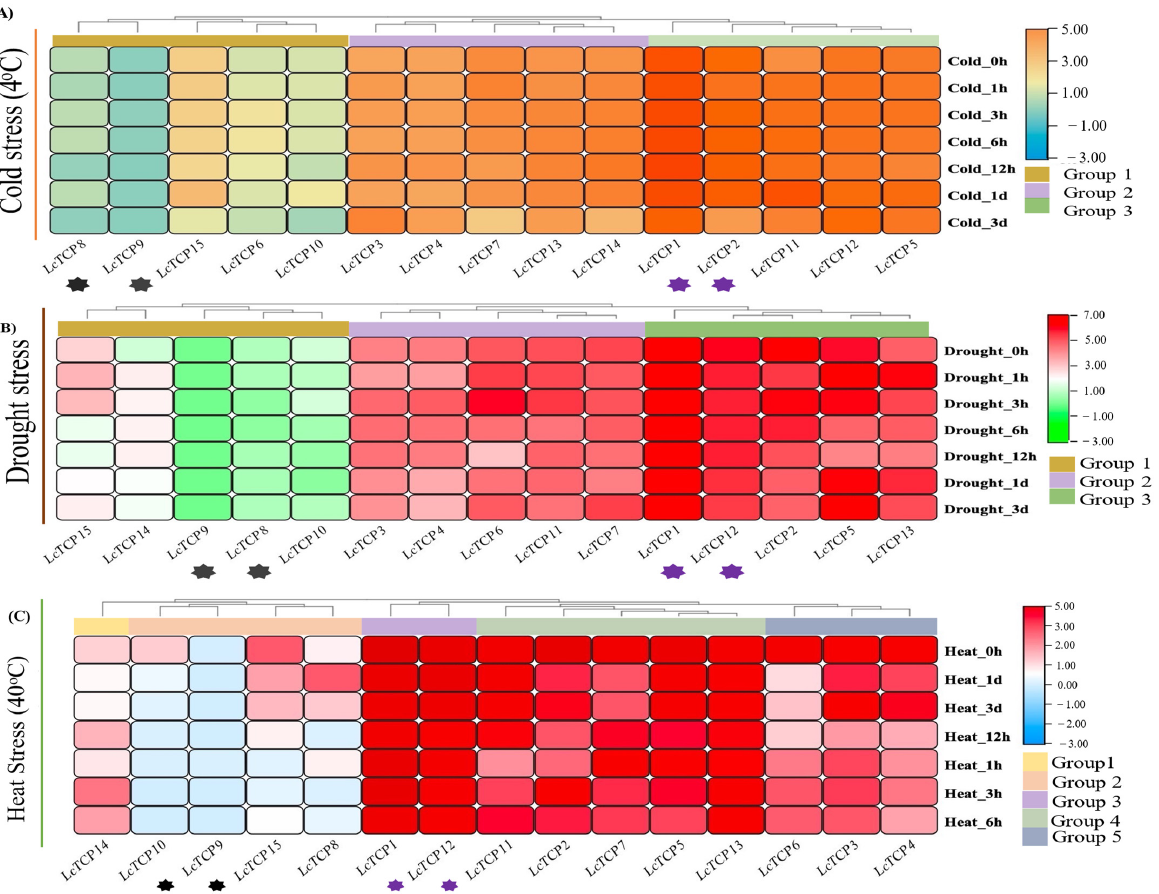
Figure 10. Expression analysis of 15 LcTCPs in six different time points, 1 h (1 h), 3 h, 6 h, 12 h, 1 day (1 d), and 3 d. Black stars depict highly downregulated genes, while purple stars show highly upregulated genes. The LcTCPs were subjected to three different stress factors; ( A ). Cold stress, ( B ). Heat stress, and ( C ). Drought Stress.